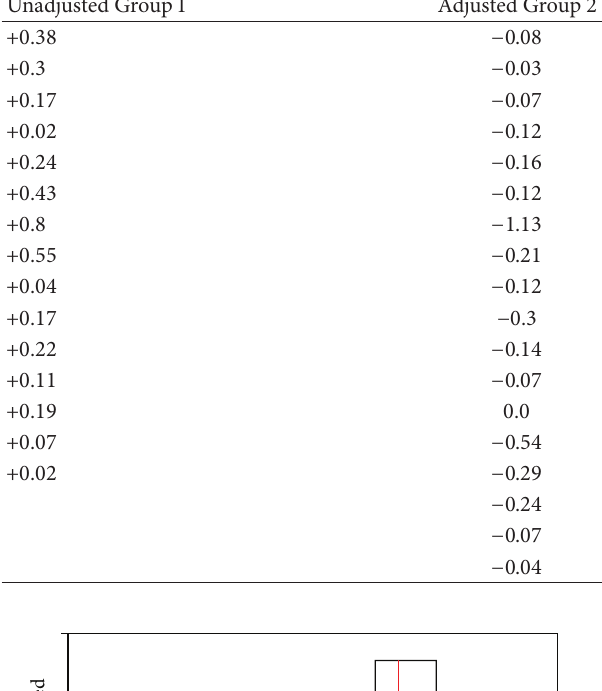
Table 1: Variations in bioimpedance of patients using unadjusted and well-adjusted elastic stockings during a 5-day program of mechanical lymph drainage.